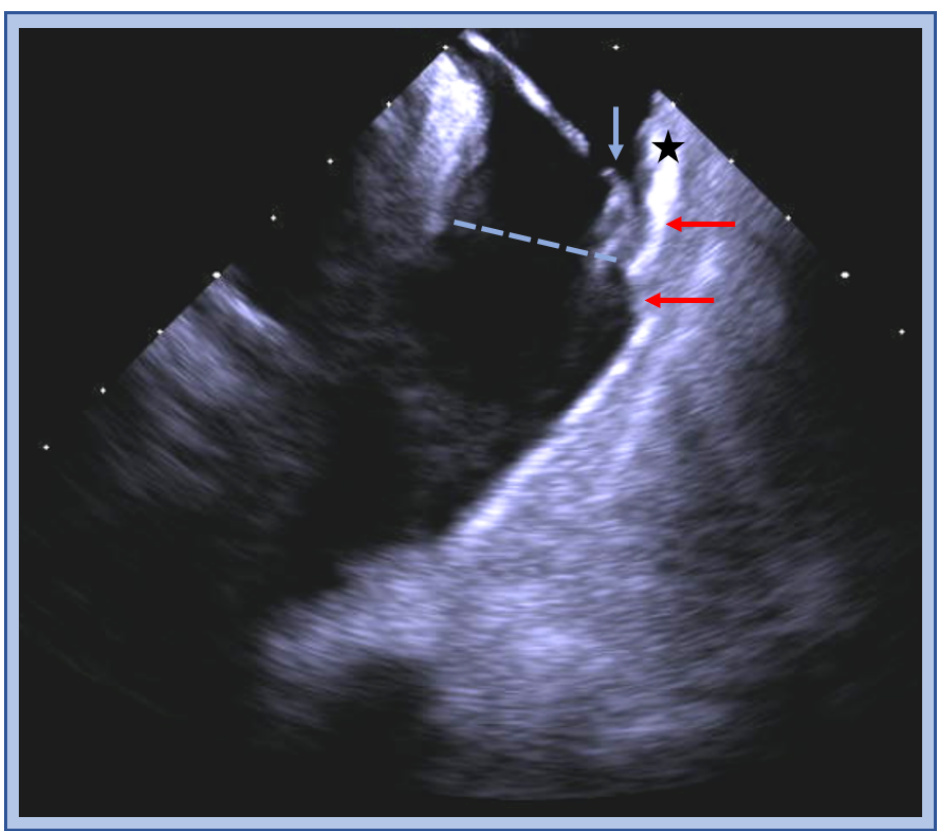
Figure 3. ICE image of the RVOT with an ablation catheter (blue arrow) positioned on the anterior wall (star) below the pulmonic valve plane (blue dashed line), thick muscle bundles (red arrow) are visualized above and below the valve.